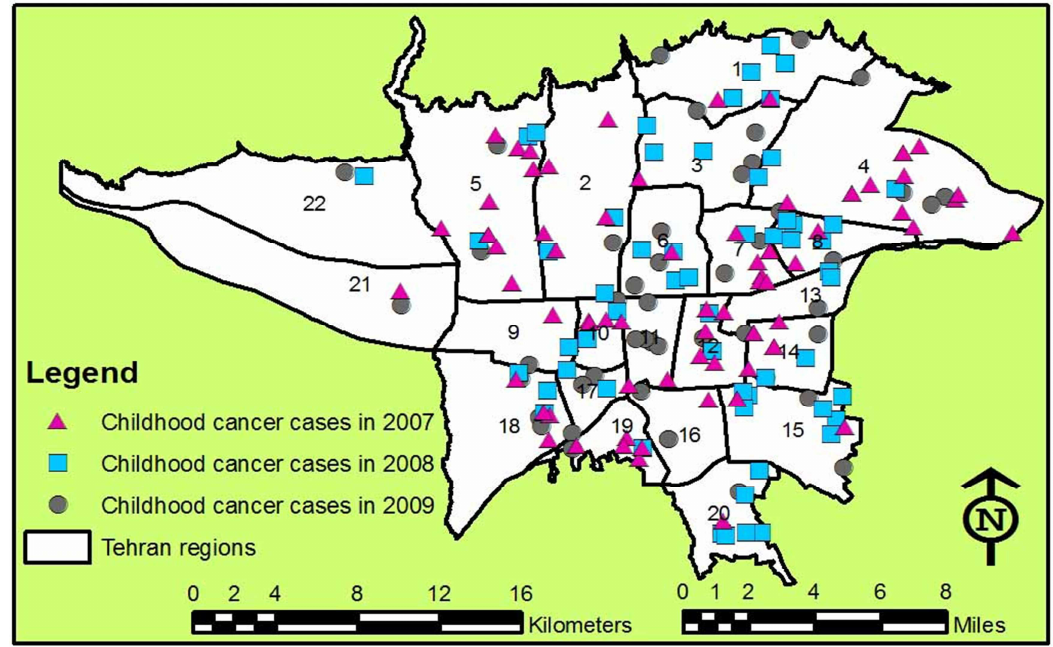
Figure 2. The spatial distribution of childhood cancer counts from 2007 to 2009 in Tehran,